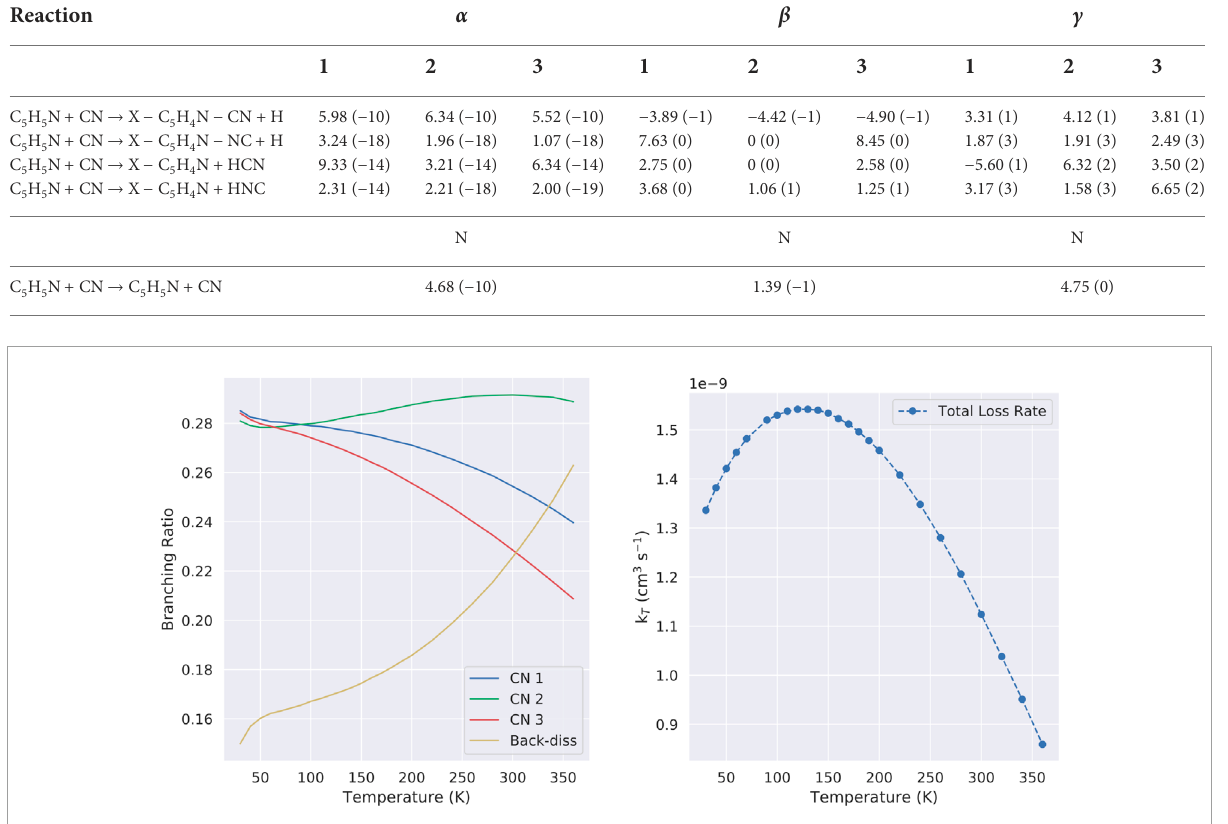
event. This higher loss rate may be partially behind the absence of pyridine in the ISM as discussed by (Barnum et al.,